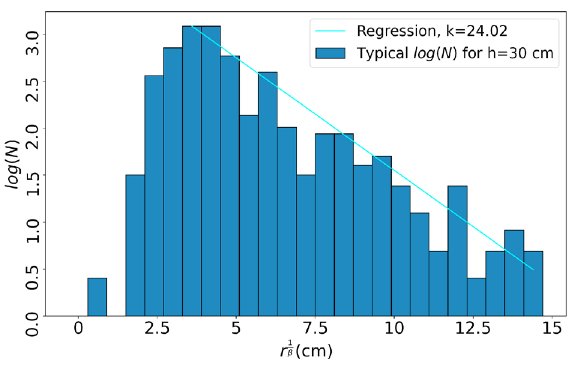
1 β with linear regression at